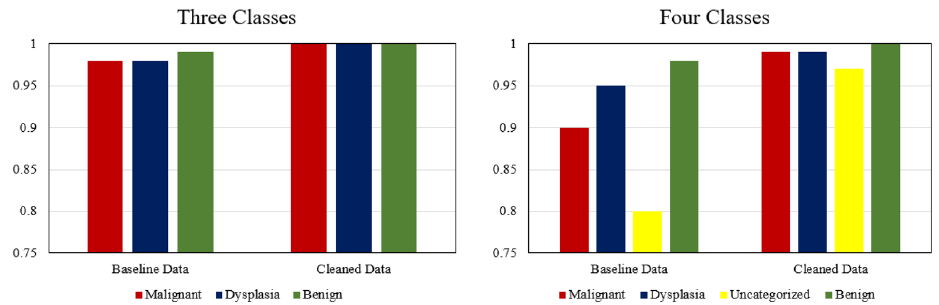
Figure 9. Difference in the area under the ROC curve for the baseline ( D b ) and cleaned data ( D c ).